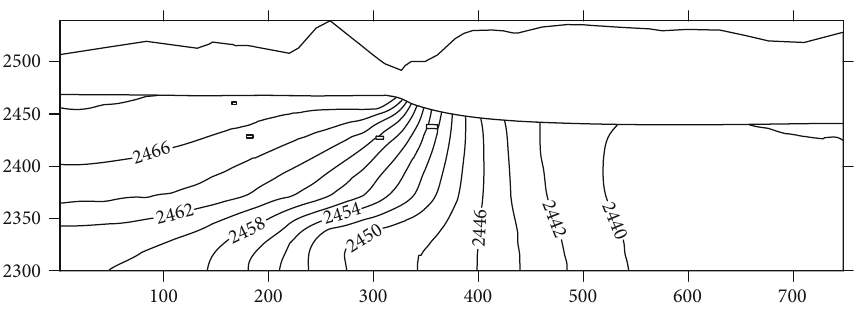
Figure 13: The isopotential distribution map of seepage fi eld about dam foundation (7-7pro fi le).